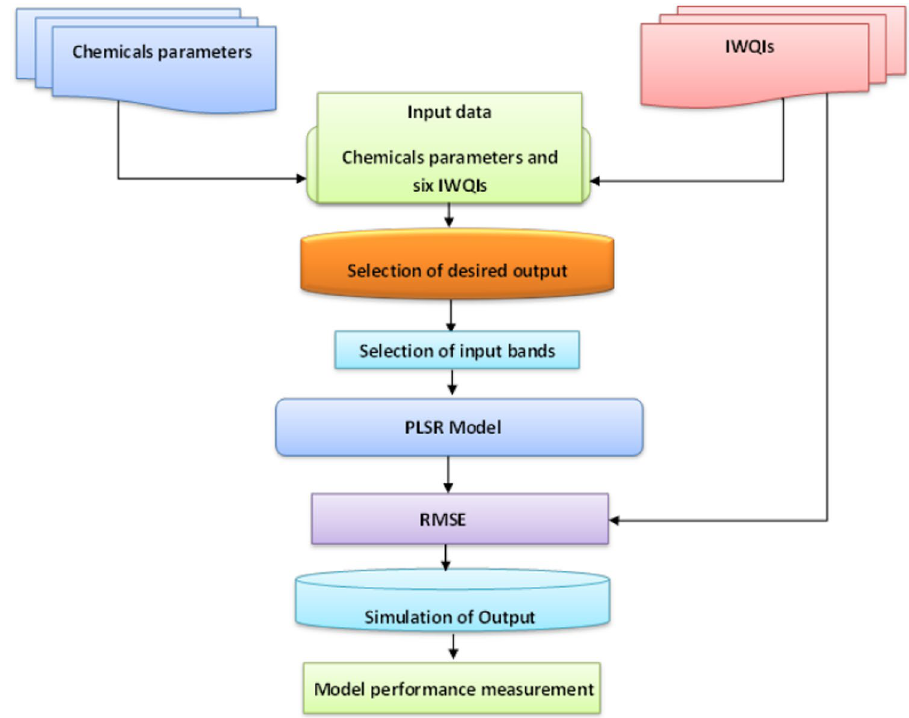
Fig. 5 Schematic diagram of the methodology of PLSR used in this study to predict IWQI, TDS, SAR, PS, MH, and RSC based on the selected chemical